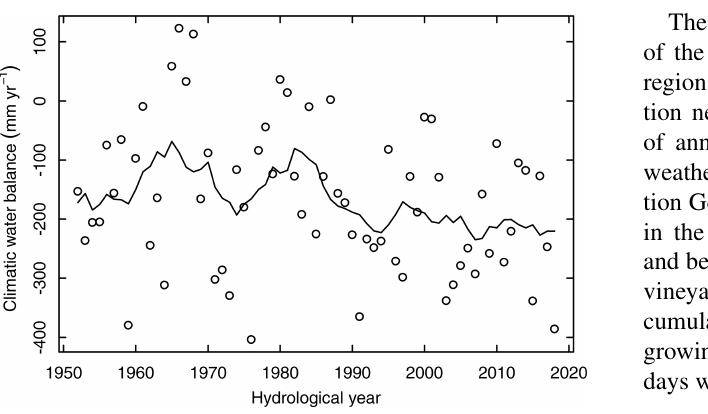
Figure 3. Climatic water balance, expressed as the difference be- tween the sum of precipitations and the sum of reference evapo- transpiration for a hydrological year (1 November–31 October) for the station Geisenheim (Rheingau), Germany. The solid line shows 11-year running mean values. The decreasing trend is significant ( p < 0 . 05, Mann–Kendall trend test; calculated with the R package Kendall; McLeod, 2011).